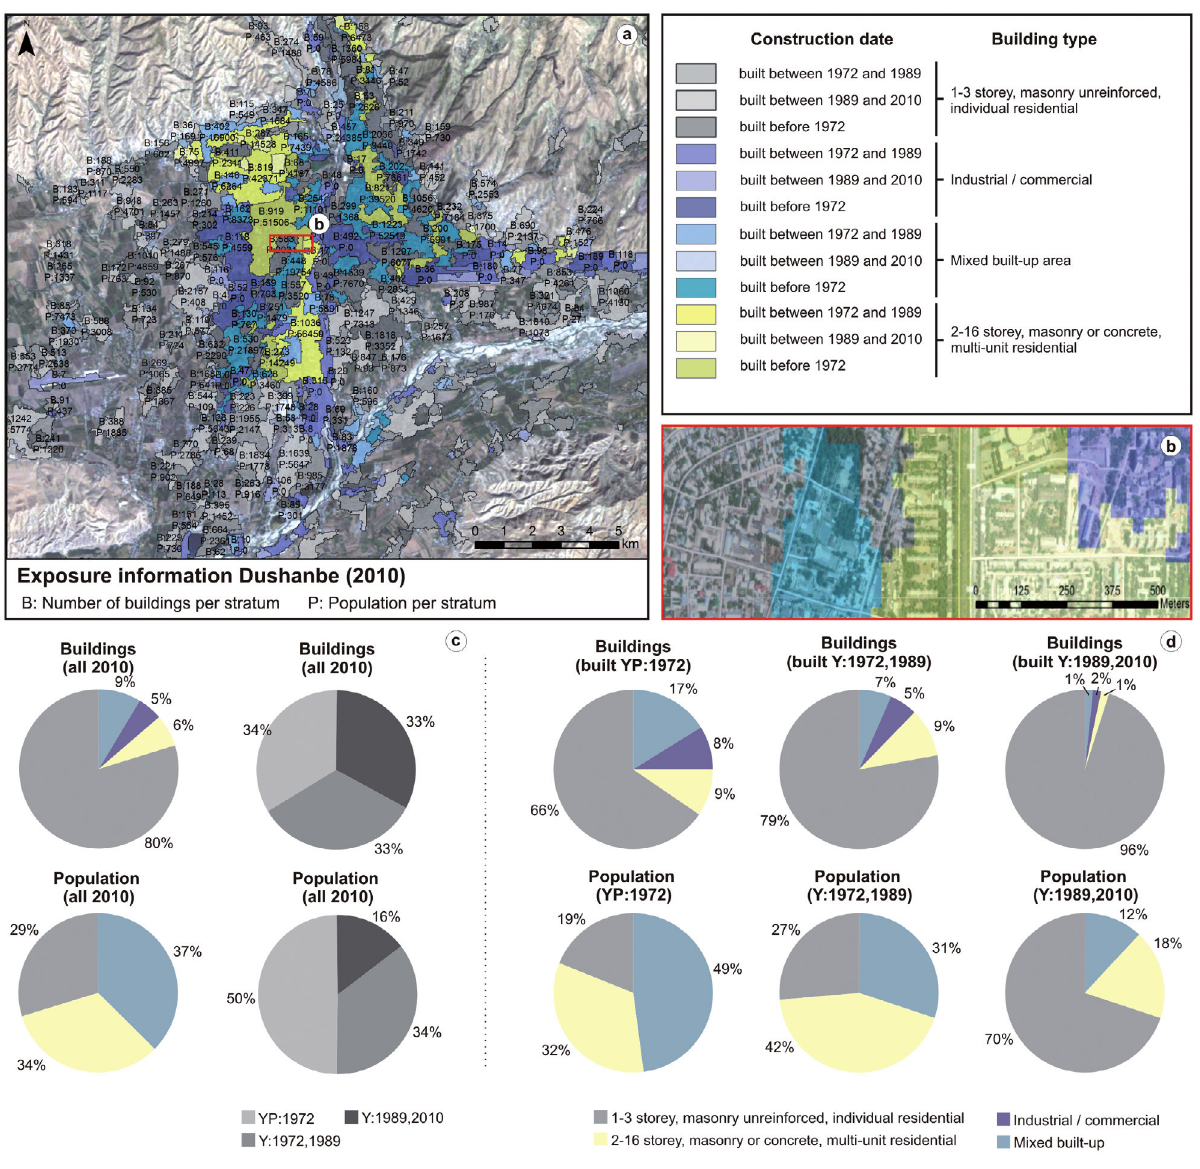
Figure 3. L2 exposure zonation from satellite images for Dushanbe, the capital of Tajikistan, with (a) Building type distribution and distri- bution of areas with similar construction date period. (b) Magnified view of the L2 exposure zonation extracted from medium-resolution satellite images and superimposed on a high-resolution image. (c) Composition of the number of buildings and the population per building type and per construction date period in Dushanbe in 2010. (d) Composition of the number of buildings and population per building types grouped by construction date